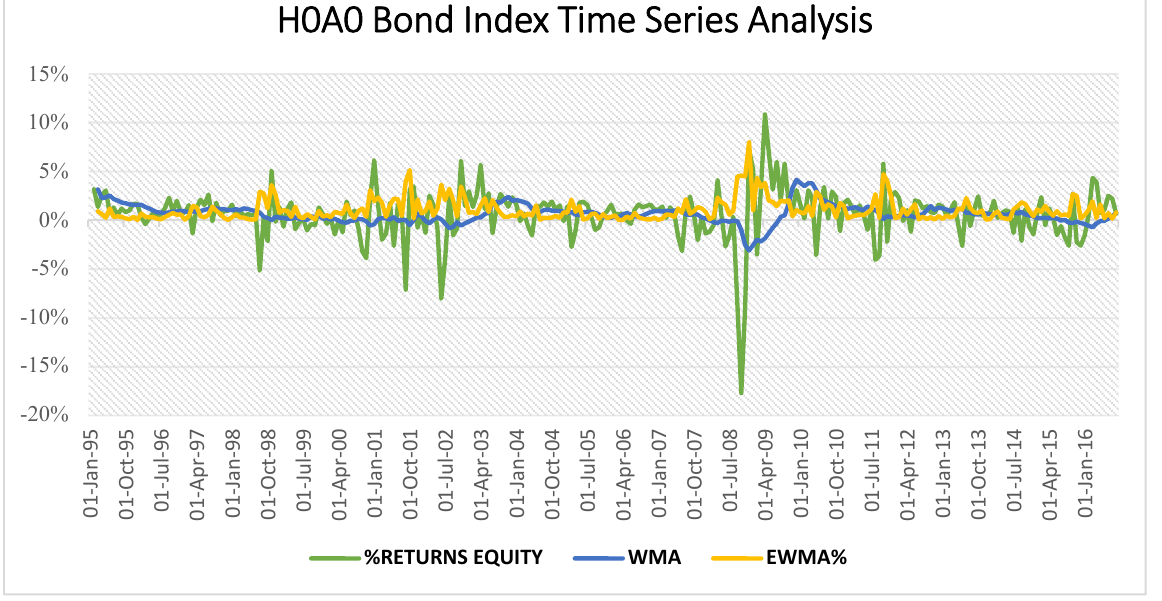
Figure 11. H0AO monthly time series analysis, bonds. Source: authors. The GBI-EM in Figure 12 tracks the emerging markets’ government bonds; by virtue of the debt being sovereign, it is generally stable, and the returns and volatility (EWMA) only spike in the stress period. The WMA is generally smooth and centred around the mean.